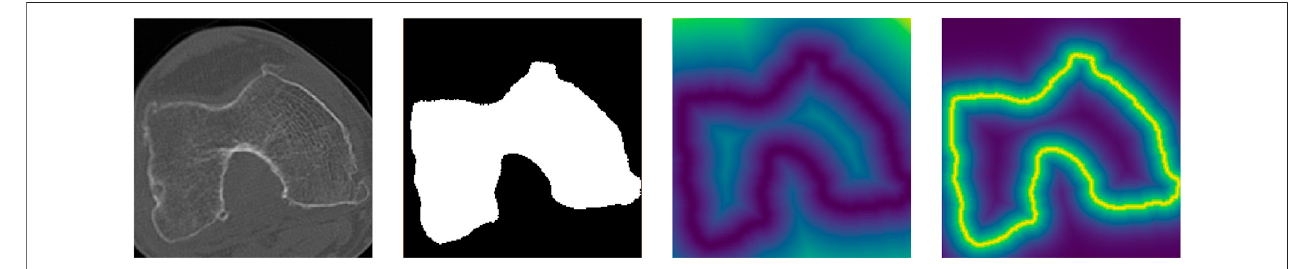
FIGURE 3 | From left to right. Original CT slice, binary image, euclidean distance transform and distance weight map (DWM). Lighter voxels in the DWM indicate shorter distances from the bone contour.